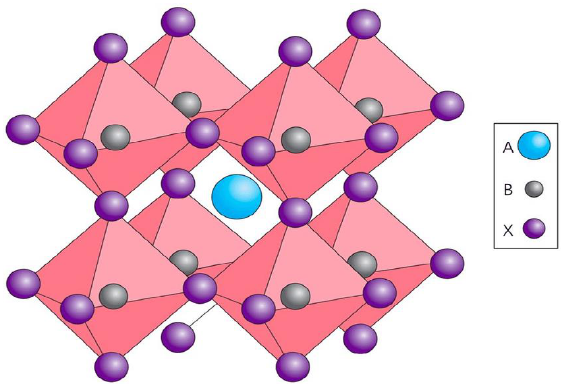
Figure 1. A typical crystal structure of a Perovskite [6].